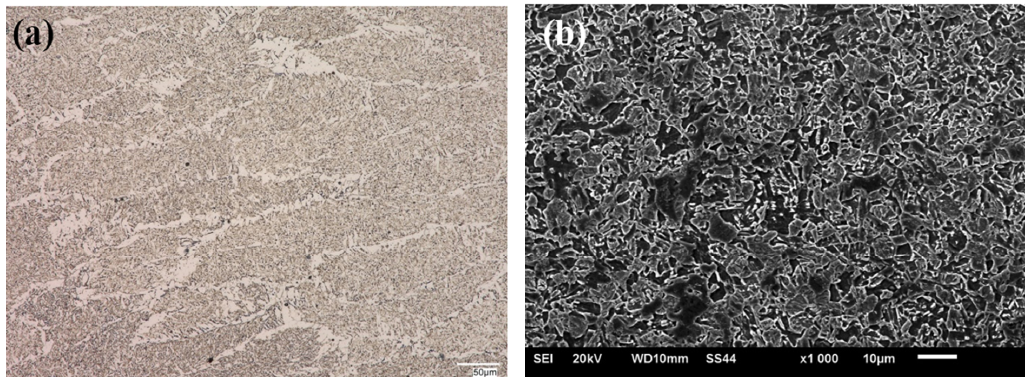
Figure 6. Microstructure of HAZ in HTK 900H steel, ( a ) OM; ( b ) SEM.